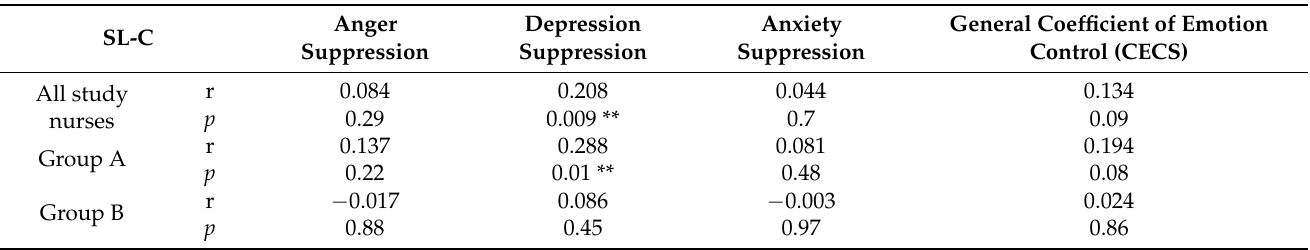
Table 4. Correlation between anxiety intensity according to the SL-C scale and emotional control